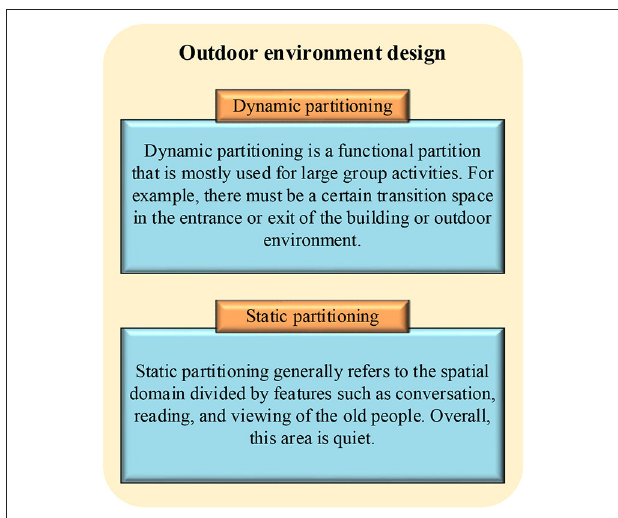
FIGURE 1 | The outdoor environment design of the elderly rehabilitation